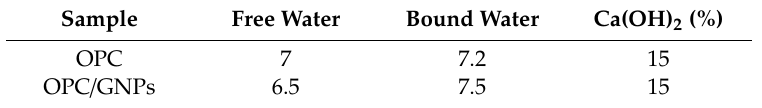
Table 1. Free water, non-evaporable water cw% and portlandite content obtained by TGA analysis. Sample